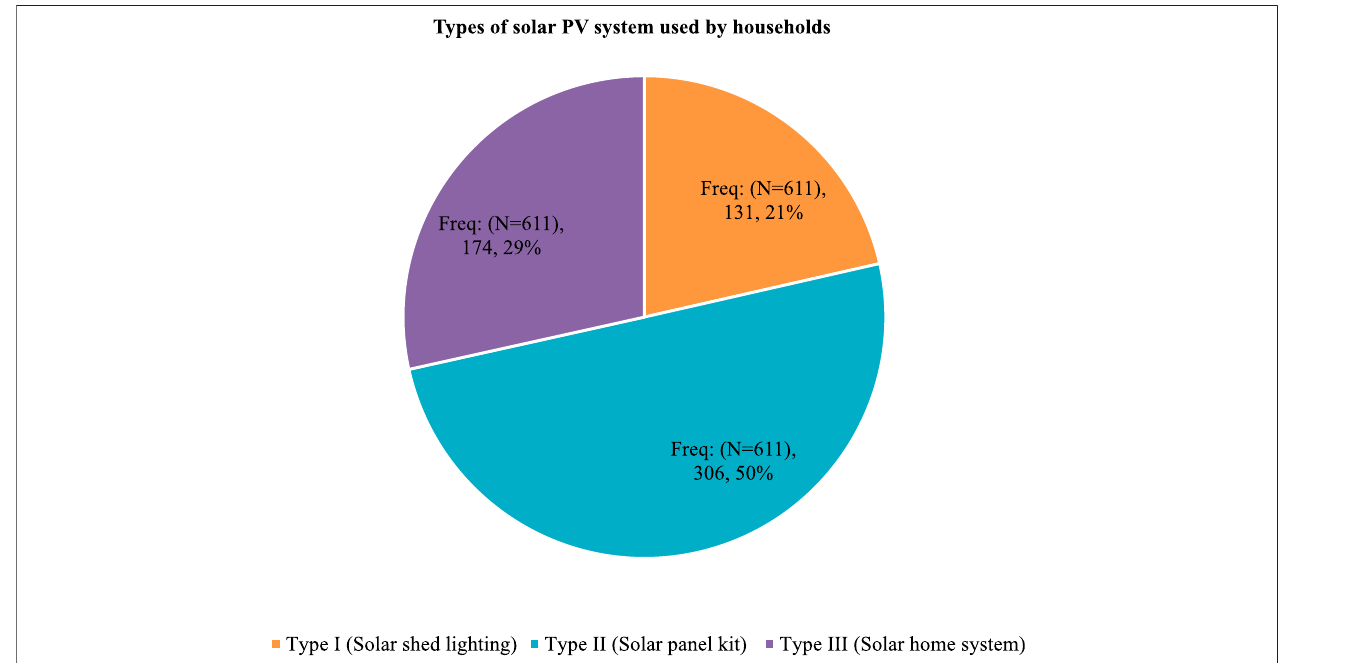
FIGURE 2 | Types of solar PV system used by households, Source: Own survey data September 2020- August 2021.